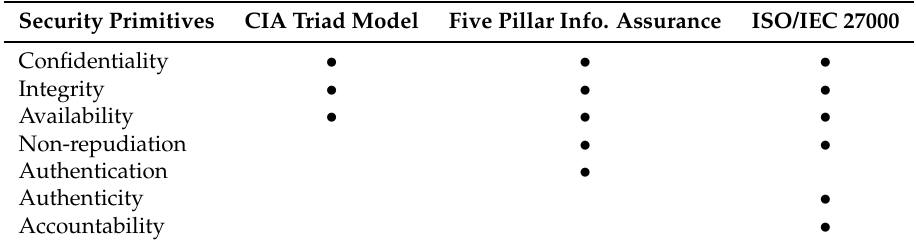
Table 1. Security primitives of data security